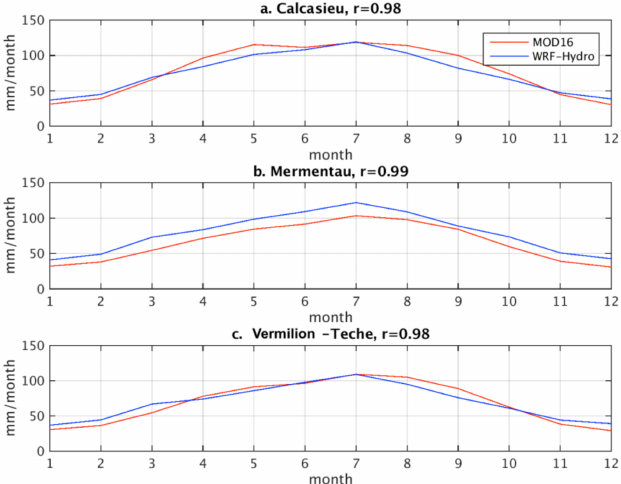
Figure 5. A comparison of monthly climatology of the evapotranspiration simulated by the Land Surface Model (blue) against satellite product (MOD16; red) for ( a ) Calcasieu, ( b ) Mermentau, and ( c ) Vermilion-Teche